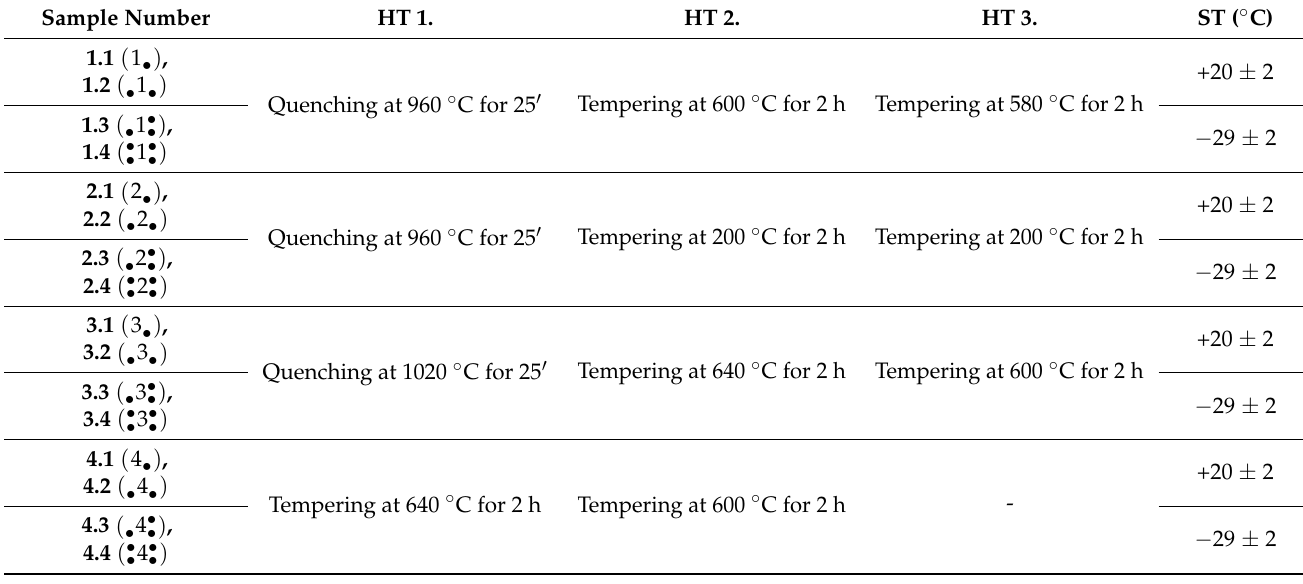
Table 6. Heat treatment of samples and temperature of